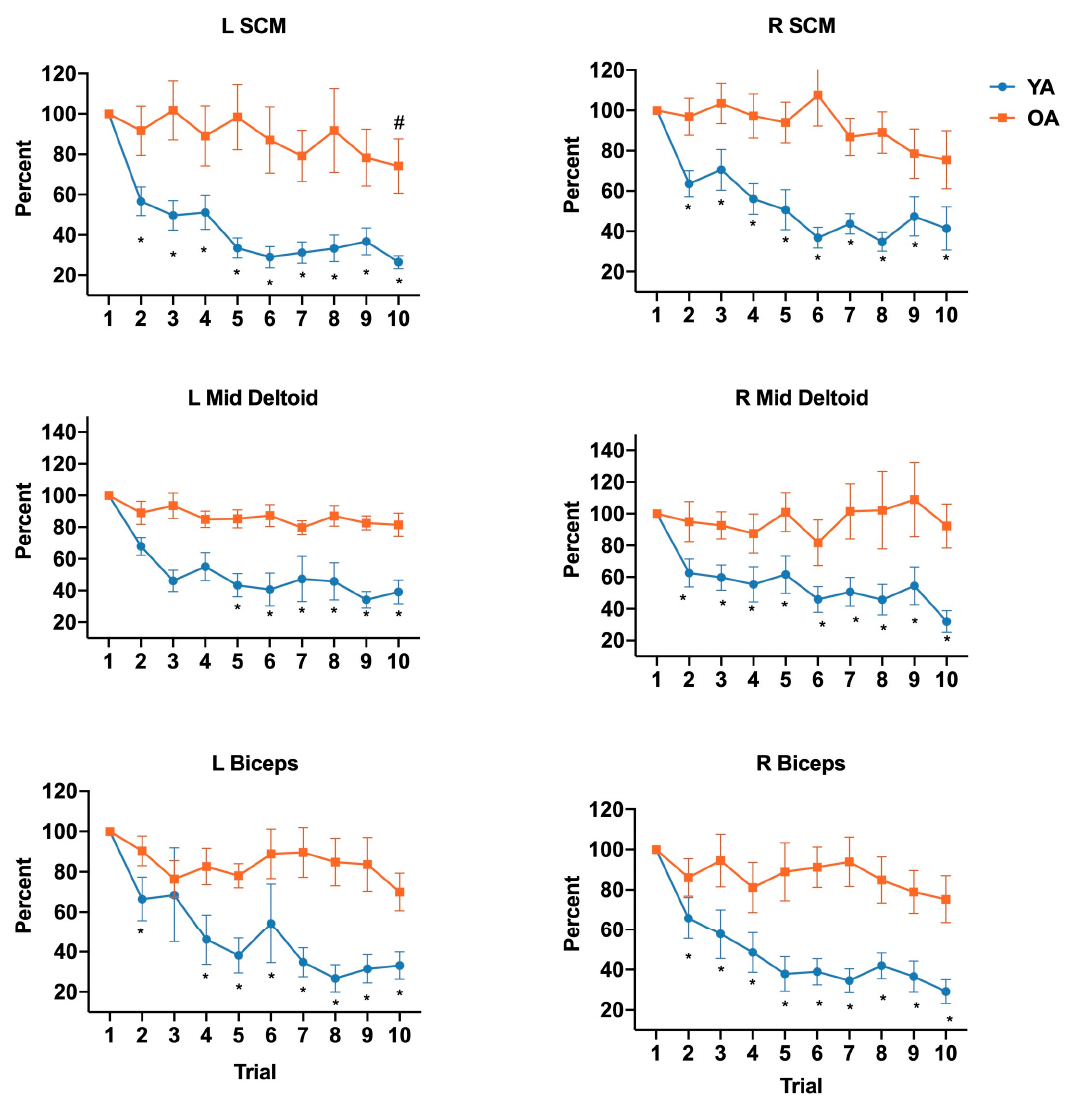
Figure 3. Age-related differences in habituation rates of muscle amplitude (right and left middle deltoid, biceps, SCM) over 10 successive trials. Values are expressed as the mean ± standard error. The asterisk (*) and hashtag (#) depict significant differences between trial 1 and subsequent trials for young and older adults, respectively.